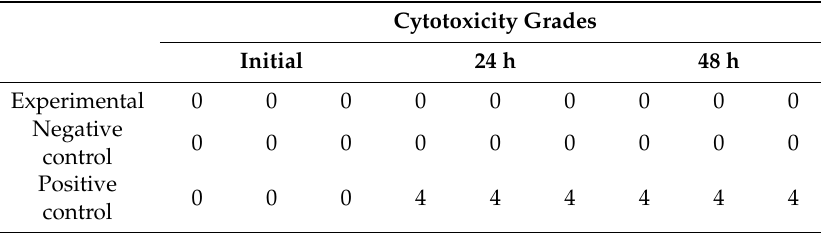
Table 2. Results of cytotoxicity tests.